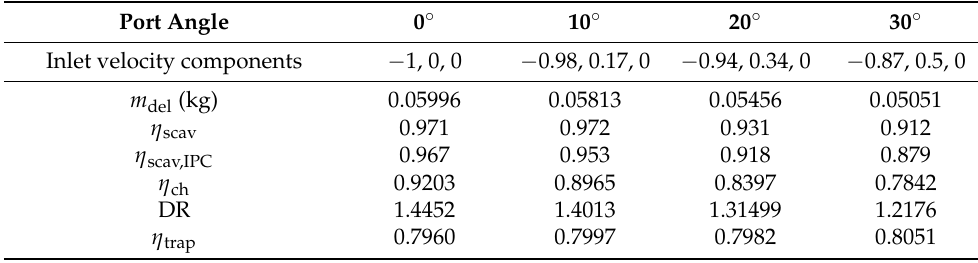
Table 8. Scavenging parameters for different scavenging port